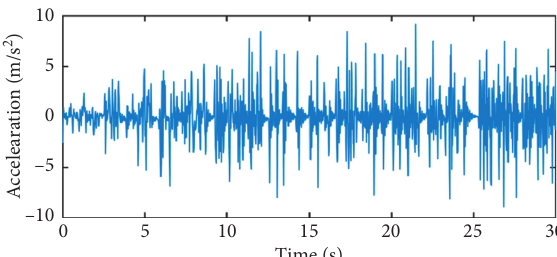
Figure 22: The scaled Wenchuan earthquake acceleration.